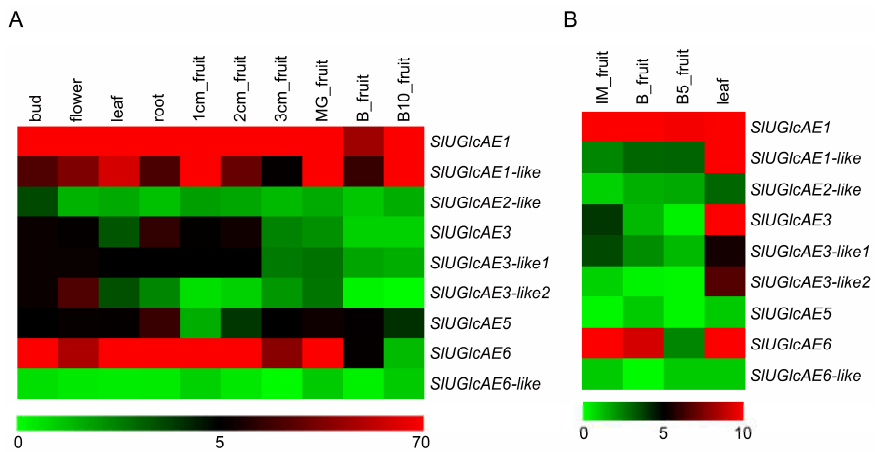
Figure 5. Heatmap analysis of UGlcAE family gene expression in various organs of tomato. ( A ) tomato cultivar Solanum lycopersicum (mature green stage (MG), breaker stage (B), ten days after breaker stage (B10)); ( B ) wild relative Solanum pimpinellifolium (immature green stage (IMG), breaker stage (B), five days after breaker stage (B5)). The expression data was gained from pubic RNA‐seq data and shown as log 2 as calculated by FPKM values (fragments per kilo base of exon model per million) mapped reads. The green boxes represent the lower expression level, whereas the red boxes represent the higher expression level.